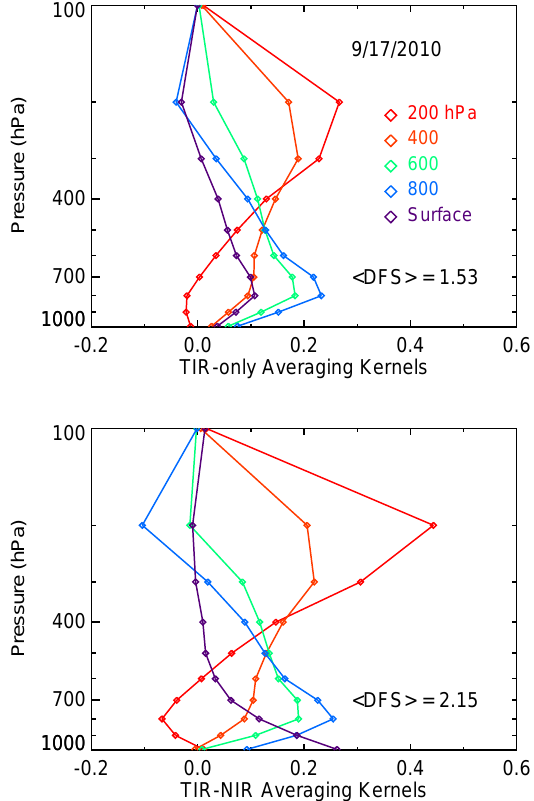
Figure 2. Comparison of mean retrieval averaging kernels for the MOPITT Version 6 TIR-only (top panel) and TIR-NIR (bottom panel) products for the western Amazon Basin (within 10–5 ◦ S, 70– 65 ◦ W) on 1 July 2010. For clarity, only the averaging kernels for al- ternating levels in the MOPITT retrieval grid (i.e., surface, 800hPa, 600hPa, etc.) are actually plotted.